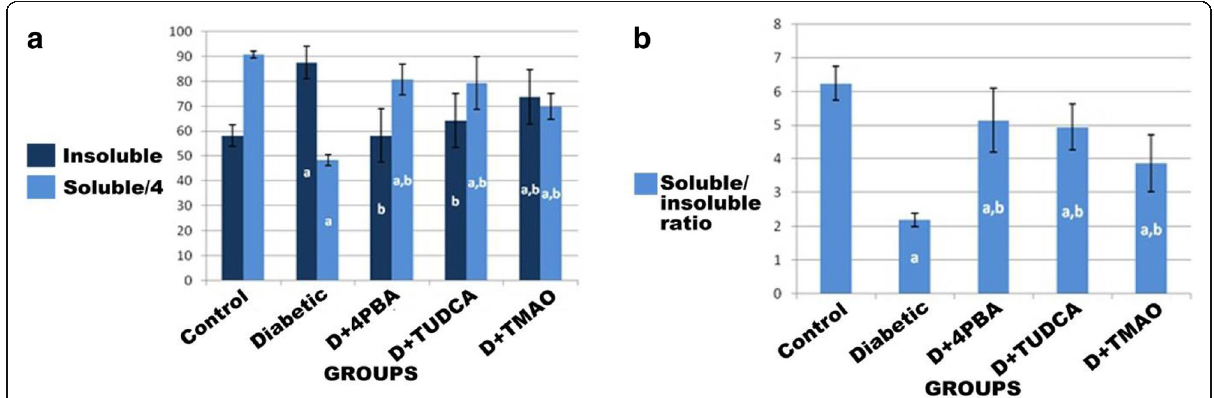
Fig. 7 Mean levels of insoluble and soluble lens proteins in control and experimental groups. a Comparison of soluble and insoluble lens protein. b Soluble/insoluble ratio of lens proteins. a P < 0.05 significant in comparing with control group. b P < 0.05 significant in comparing with diabetic model